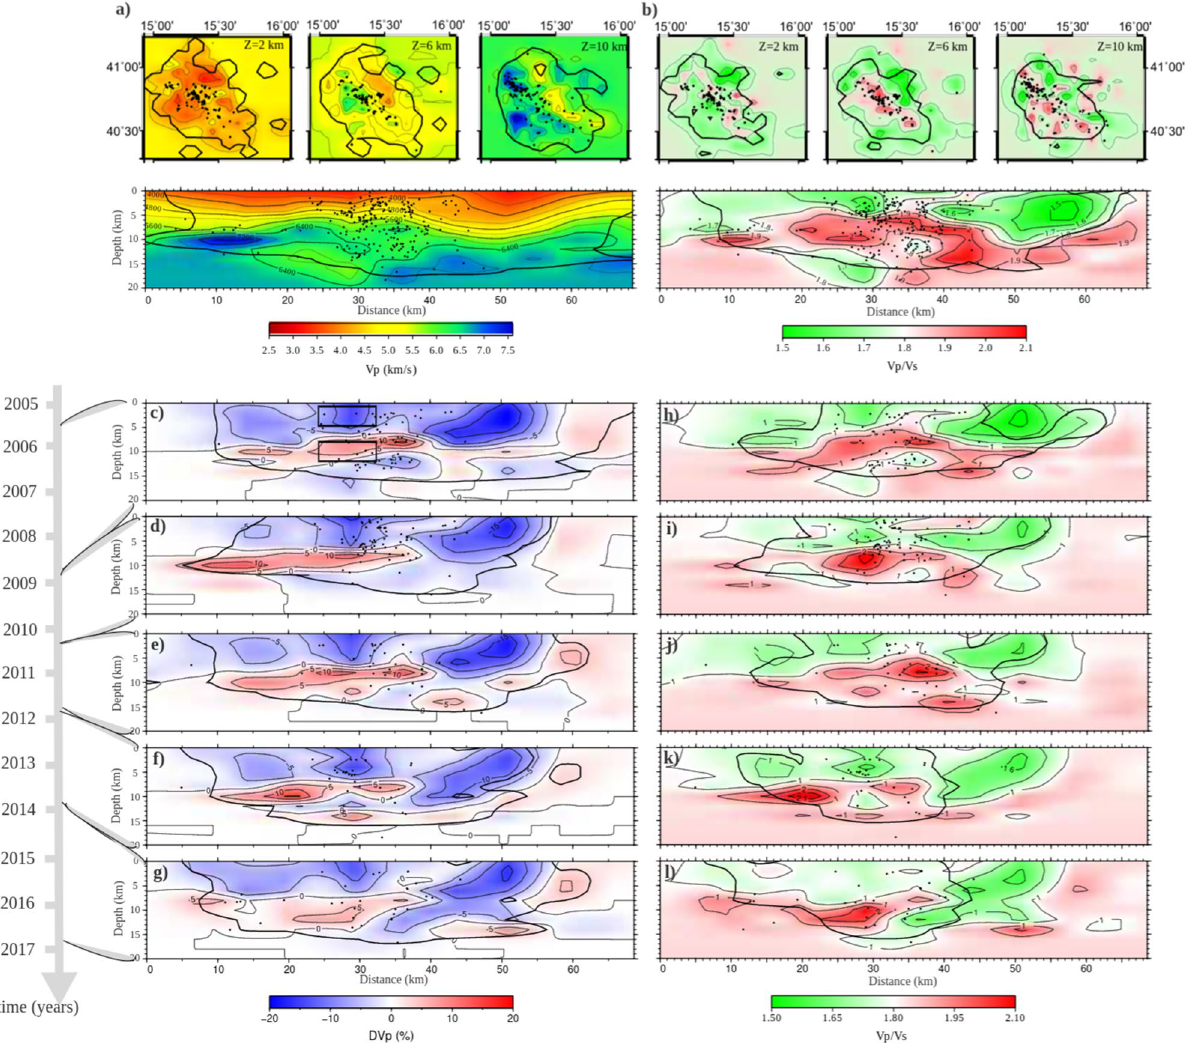
Figure 2. Three-dimensional tomographic models. ( a ) V P and ( b ) Vp-to-Vs horizontal slices for parametrization 6 × 6 × 2 km 3 at different depths (2, 6 and 10 km) and cross-sections located in Fig. 1a. The black curves delimit the well-resolved model regions according to the resolution analysis (Supplementary Figs. S3– S4). The black dots represent the earthquakes located in a range of 1 km around each layer depth. ( c – g ) Vp variations with respect to the 1D initial model and ( h – j ) Vp-to-Vs model cross-sections in the different epochs. The grey arrow shows the temporal axis and the temporal reference of each epoch. The black curves delimit the well-resolved model regions according to the resolution analysis (Supplementary Figs. S6–S7). The black squares in panel c represent the two volumes of interest. The maps were generated with the Generic Mapping Tool Software (GMT ver.4; https:// www. soest. hawaii. edu/ gmt/).